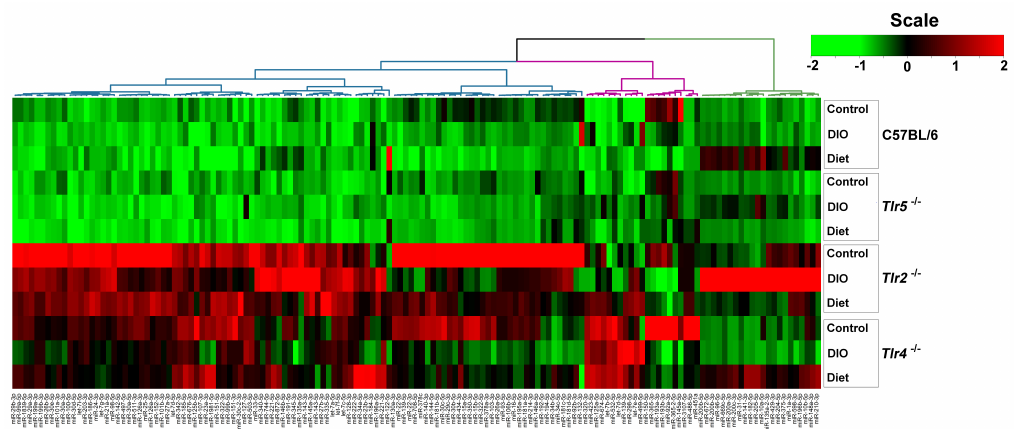
Figure 3. Unsupervised clustering of the dysregulated miRNAs of C57BL/6 and Tlr knockout mice in the control and DIO groups, obtained on the twelfth week.